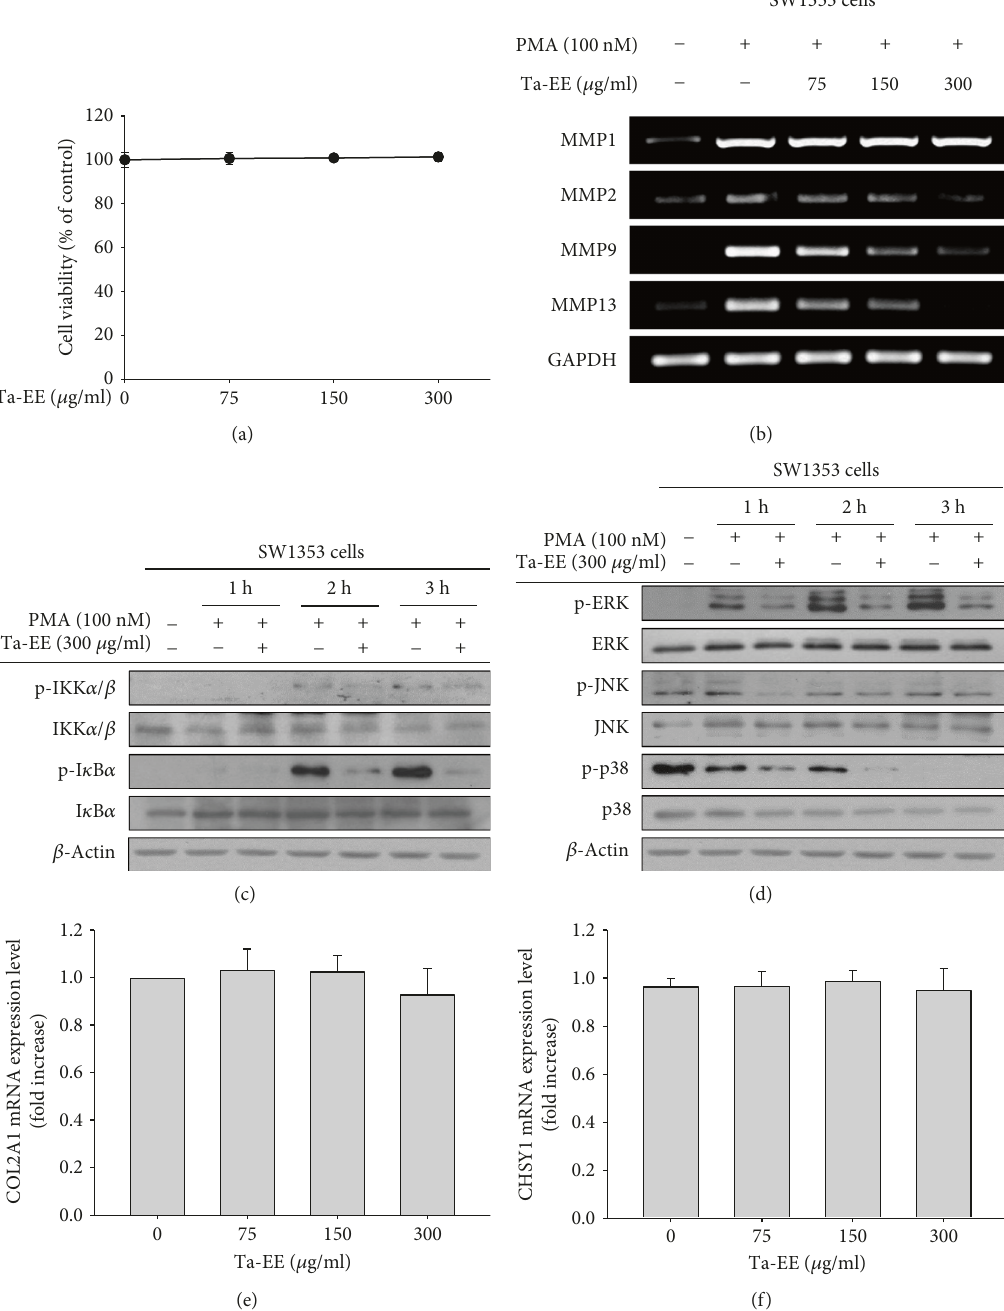
Figure 5: Ta-EE exerted a chondroprotective e ff ect by downregulating MMP gene expression rather than upregulating the gene expressions of COL2A1 and CHSY1 in SW1353 cells. (a) SW1353 cells were treated with Ta-EE (0 – 300 μ g/ml) for 24 h, and cell viability was measured by MTT assay. (b) SW1353 cells pretreated with Ta-EE (0 – 300 μ g/ml) for 30 min were treated with PMA (100nM) for 6 h, and the mRNA expression levels of MMP1, MMP2, MMP9, and MMP13 in the cells were measured by semiquantitative PCR. SW1353 cells pretreated with Ta-EE (300 μ g/ml) for 30min were treated with PMA (100nM) for the indicated time, and the total and phosphorylated protein levels of (c) IKK α / β and I κ B α and (d) ERK, JNK, and p38 in the total cell lysates were determined by Western blotting. β -Actin was used as an internal control. (e) SW1353 cells were treated with Ta-EE (0 – 300 μ g/ml) for 6 h, and the mRNA expression levels of COL2A1 and CHSY1 in the cells were measured by quantitative real-time